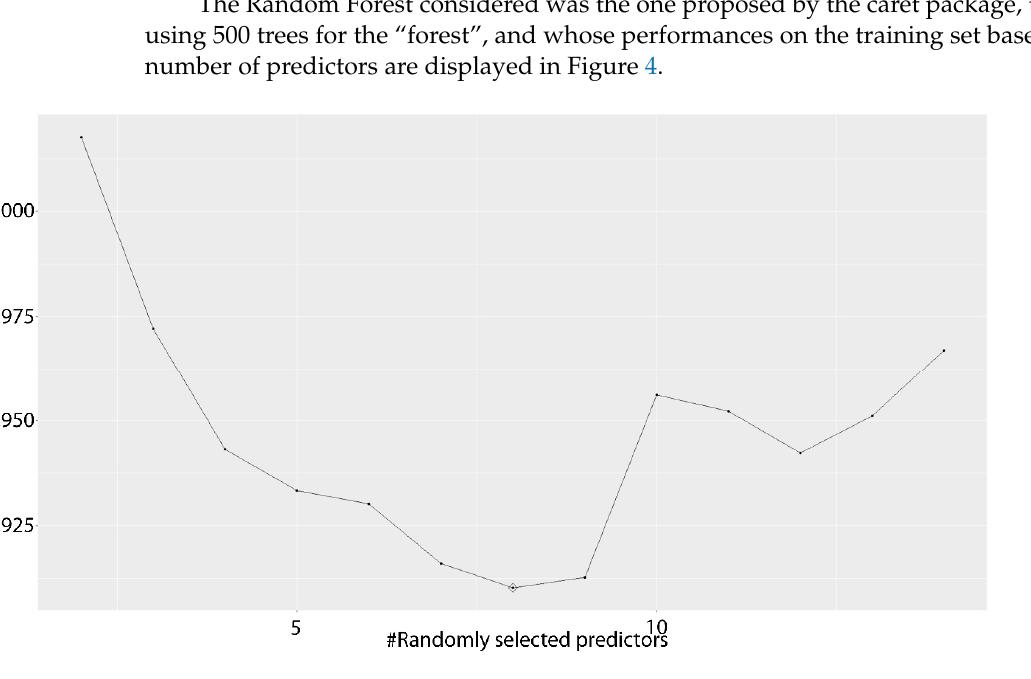
Figure 5. Error variation on the training set for the Random Forest based on the number of trees. According to the evidence obtained, the best-performing Random Forest model made best use of randomly selected 8 out of the 14 parameters included in the dataset. According to the variable importance displayed, the first eight turn out to be: MMSE at recruitment, folate, MCV, PTH, creatinine, vitamin B12, TSH, and hemoglobin, deemed to be the most useful predictors to this extent. However, the importance of platelets is